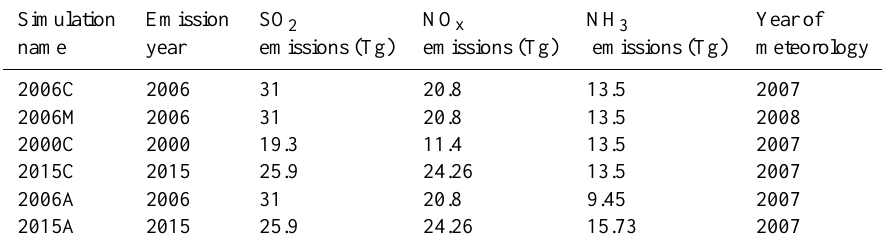
Table 1. Simulation description. Simulation Emission SO